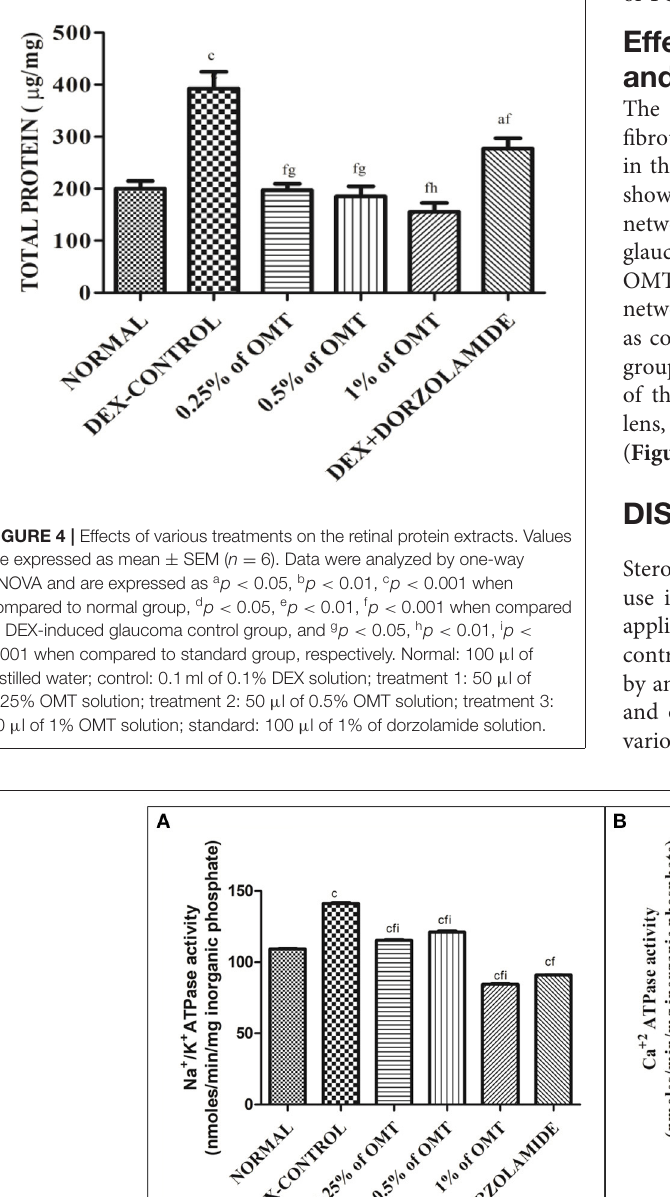
Frontiers in Medicine |